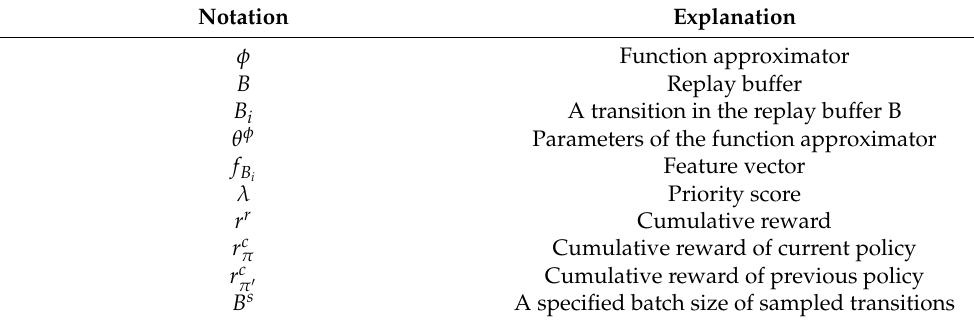
Figure 2. An illustration of experience replay optimisation (ERO). A specified batch size of transitions is sampled from the replay buffer, using a replay policy (deep neural network), to train the agent. When the buffer is full, the First-In-First-Out (FIFO) retention strategy is applied to ensure that older transitions are replaced with newer ones. Table 2. Symbols and notations used in this section.